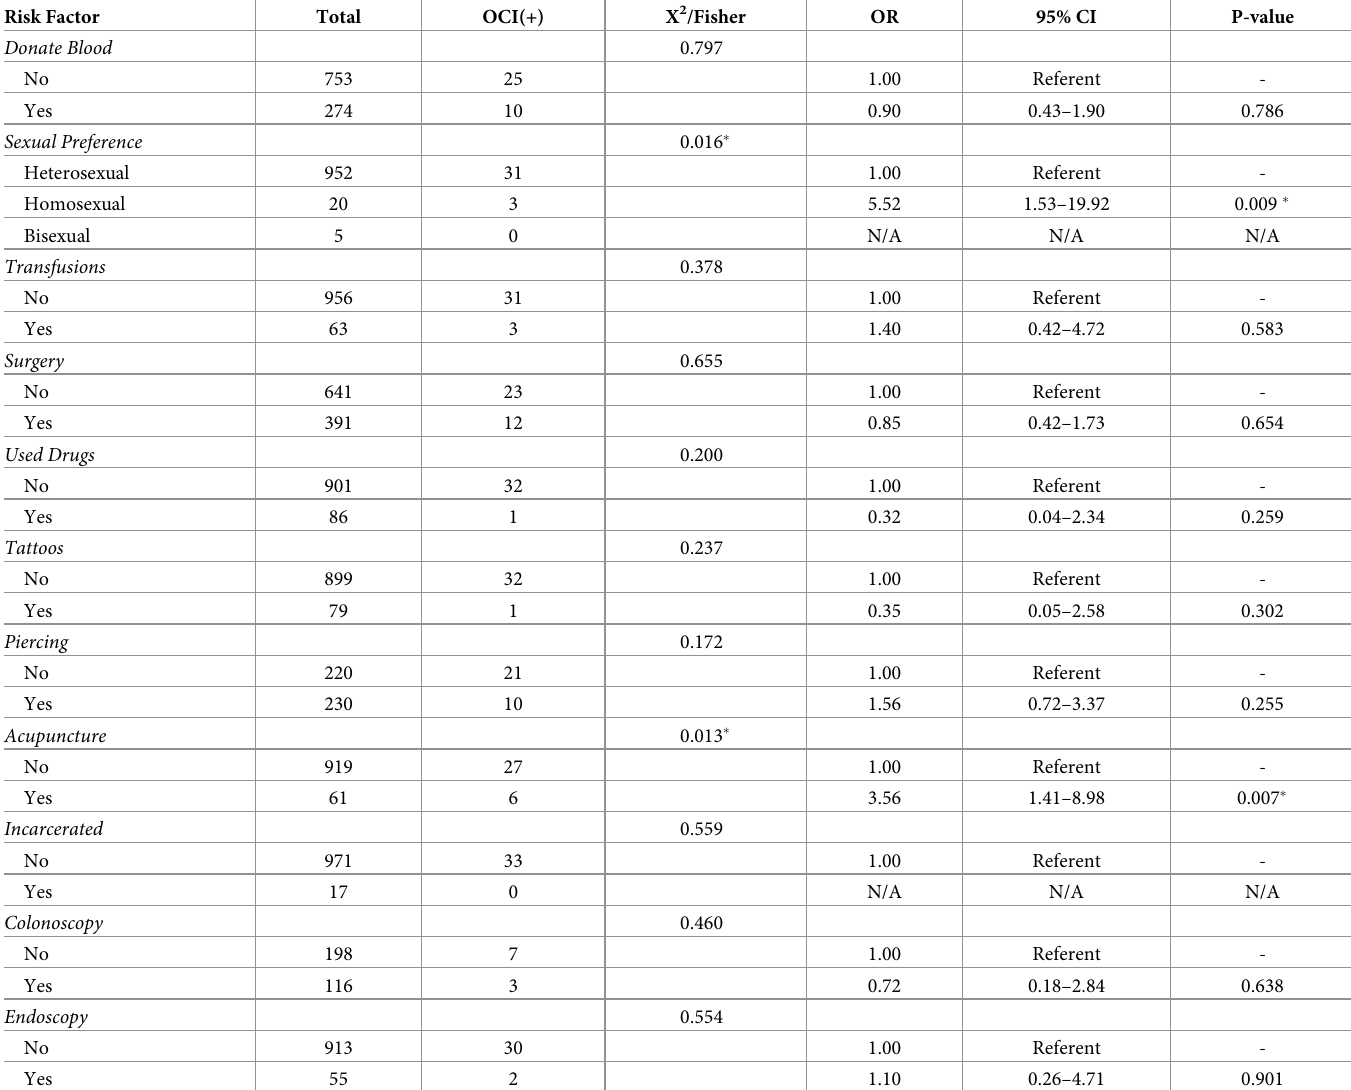
Table 2. Lifestyle factors associated with Occult HCV